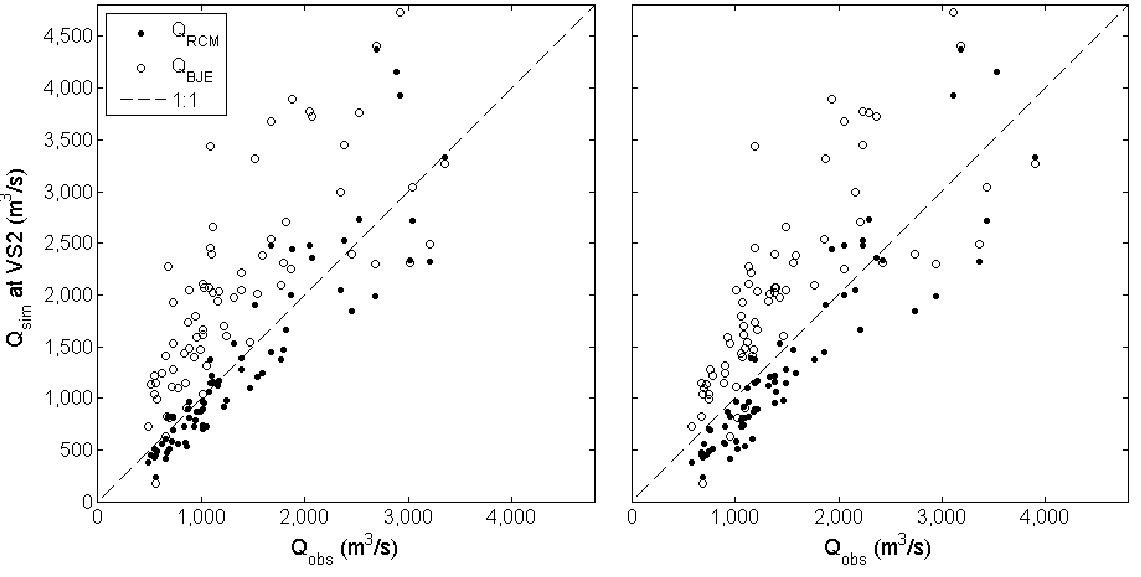
Table 5. VS2 and VS3: comparison between the discharge derived from RCM and the empirical equation derived by Bjerklie et al. (2003) and the ones observed at Sermide